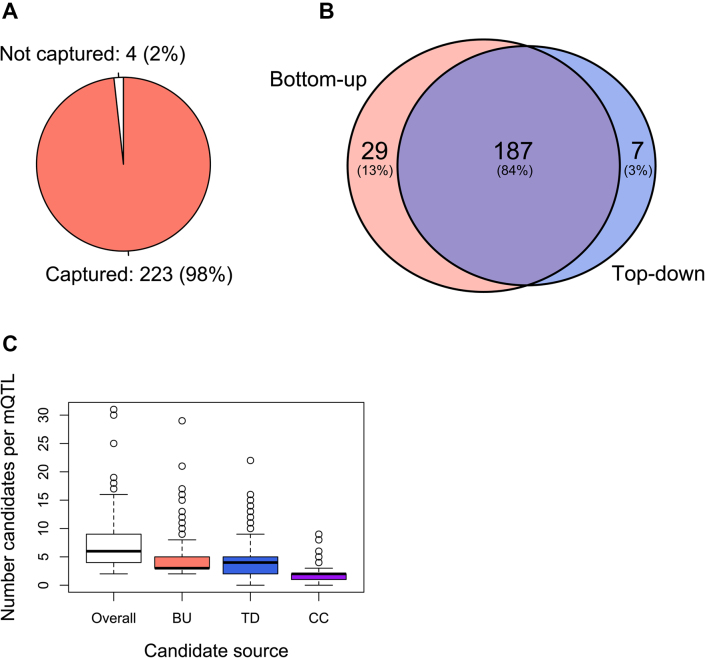
Global benchmarking of ProGeM using high-confidence causal gene assignments at 227 mQTLs. (A) Number (percentage) of high-confidence candidate causal genes captured by our framework. (B) Summary of the number of high-confidence causal genes captured either uniquely or by both the bottom-up and top-down components of ProGeM. (C) Box plot summarizing the number of candidate causal genes identified for each mQTL by our framework overall (total), as well the bottom-up (BU) and top-down (TD) components uniquely and concurrently (CC). The box plot shows the median and interquartile ranges, with the whiskers extending to 1.5 times the corresponding interquartile range. Data points outside of this range are indicated individually as circles.